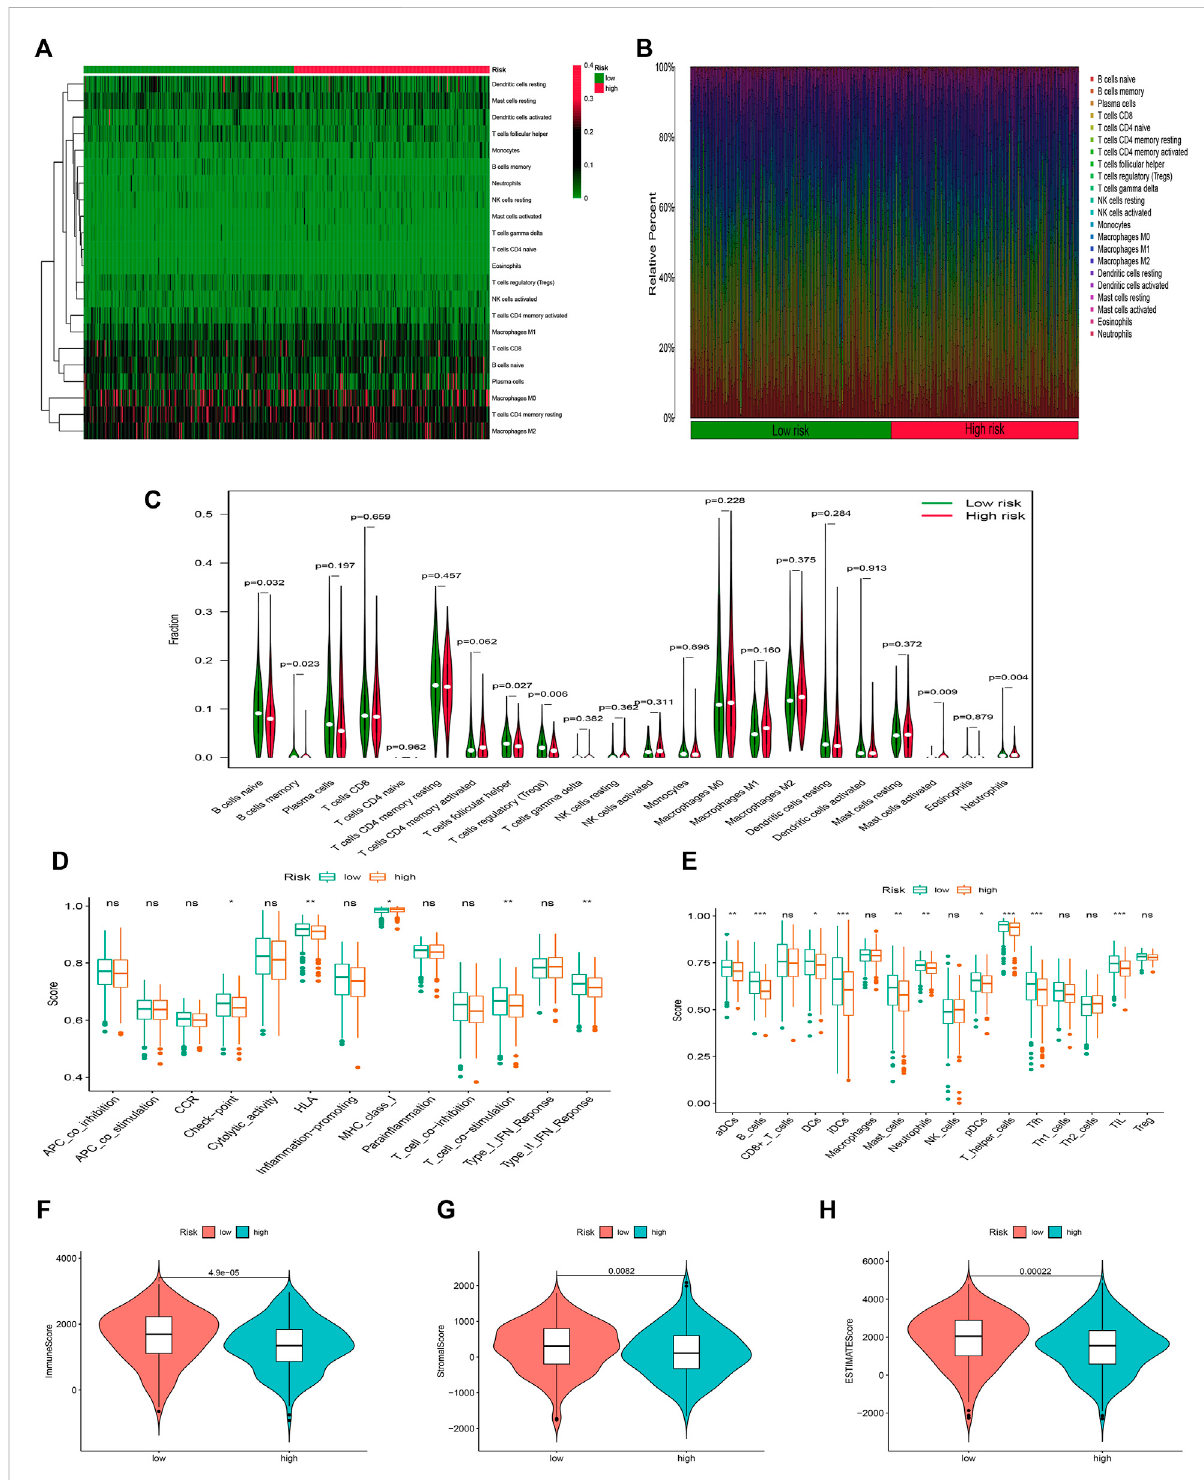
FIGURE 8 Strati fi cation Analysis of the FAM-related lncRNA prognostic risk score in immune features. (A – C) Heatmap, bar chart, and relative in fi ltrating proportion of 22 tumor-in fi ltrating immunecell types in tworisk groups. (D , E) The score of immune functionscomparing two riskgroups by ssGSEA or ssGSEA score. (F – H) The comparison of immune-related scores between high- and low-risk